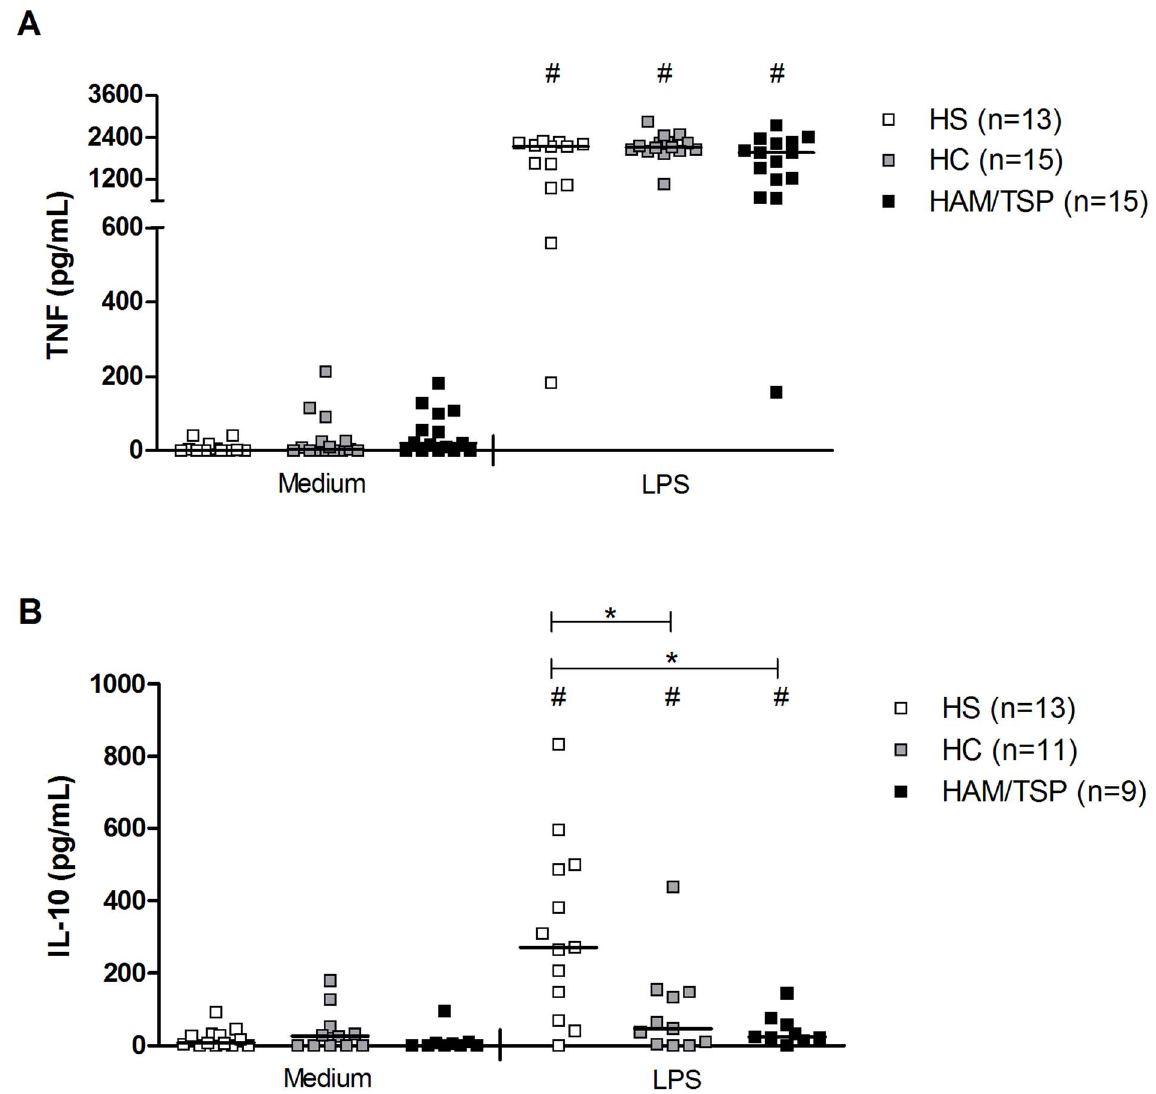
Fig. 4. Production of TNF and IL-10 by macrophages from HTLV-1 infected subjects. Macrophages from healthy subjects (HS), HTLV-1 carriers (HC) and from HAM/TSP patients were cultured without stimulus, or with LPS for 48 hours to evaluate (A) TNF and (B) IL-10 productions. ELISA was used to measure these cytokines levels. Data is represented by median and range. Kruskal-Wallis followed by Dunn’s post test (* P , 0.05) and Wilcoxon T test ( # P , 0.05) were used for statistical